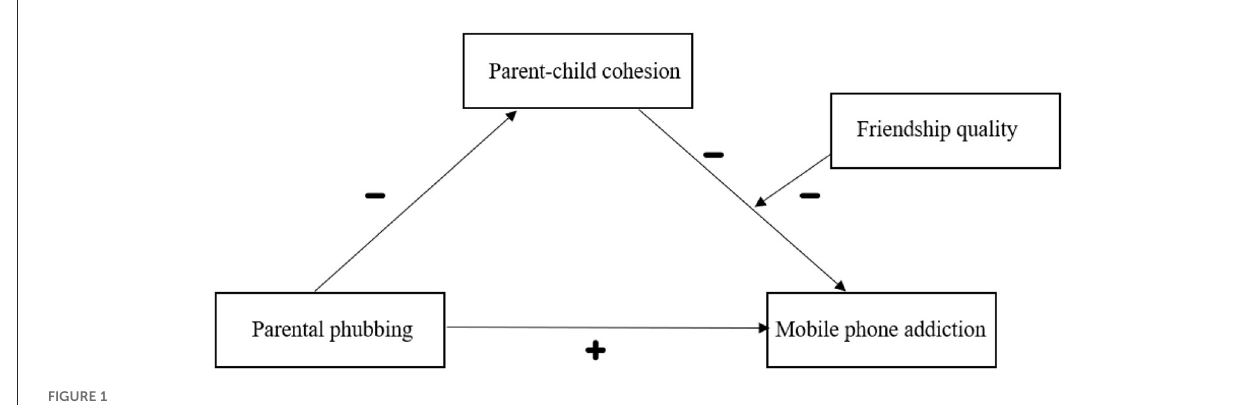
FIGURE1 The hypothetical